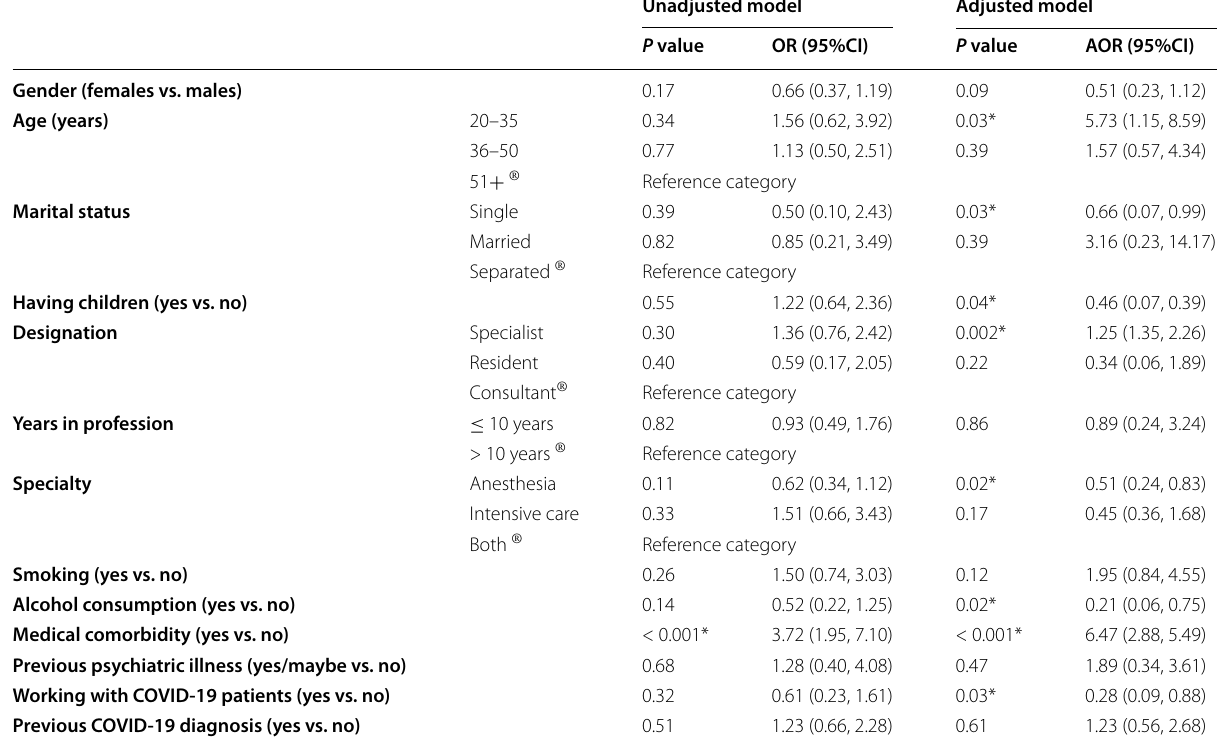
OR odds ratio, AOR adjusted odds ratio, CI confidence interval *Statistically significant at p <